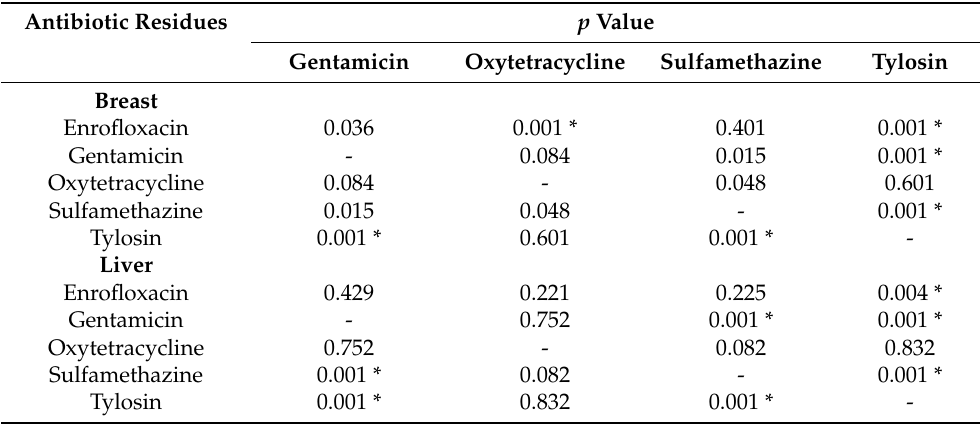
Table 4. Comparisons of antibiotic residue concentrations ( µ g/kg) among different organs of chicken by Mann–Whitney tests using Bonferroni correction at a 0.005 level of